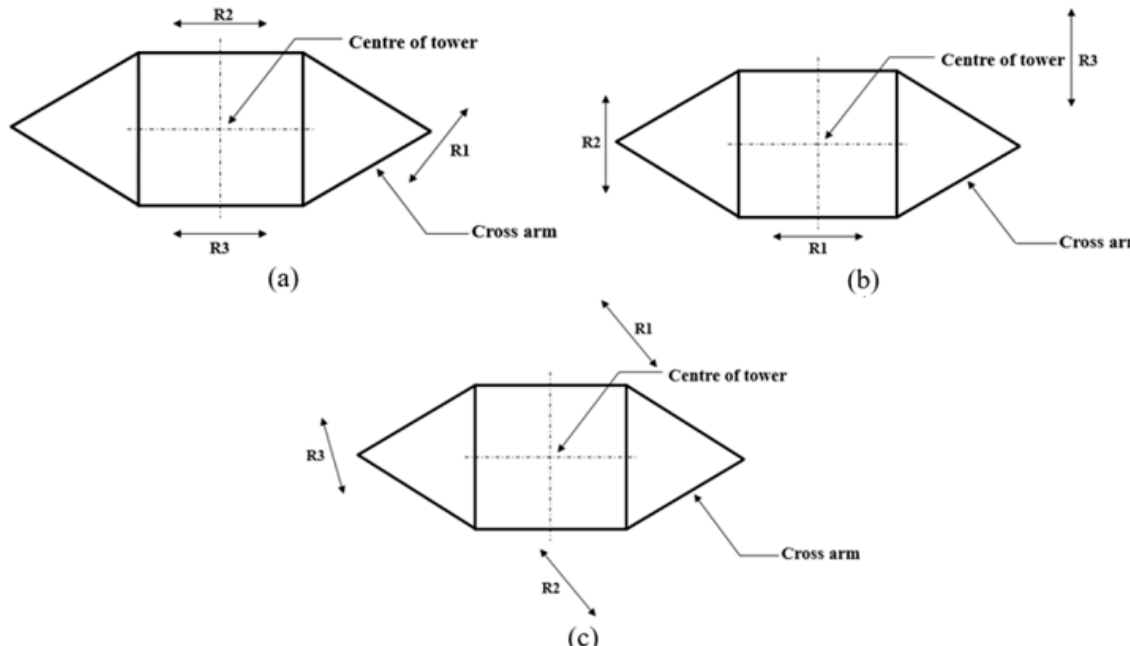
Figure 4. Top view: Apparent resistance measurements at different location areas ( a ) Tower T40 ( b ) Tower T43 ( c ) Tower T44.